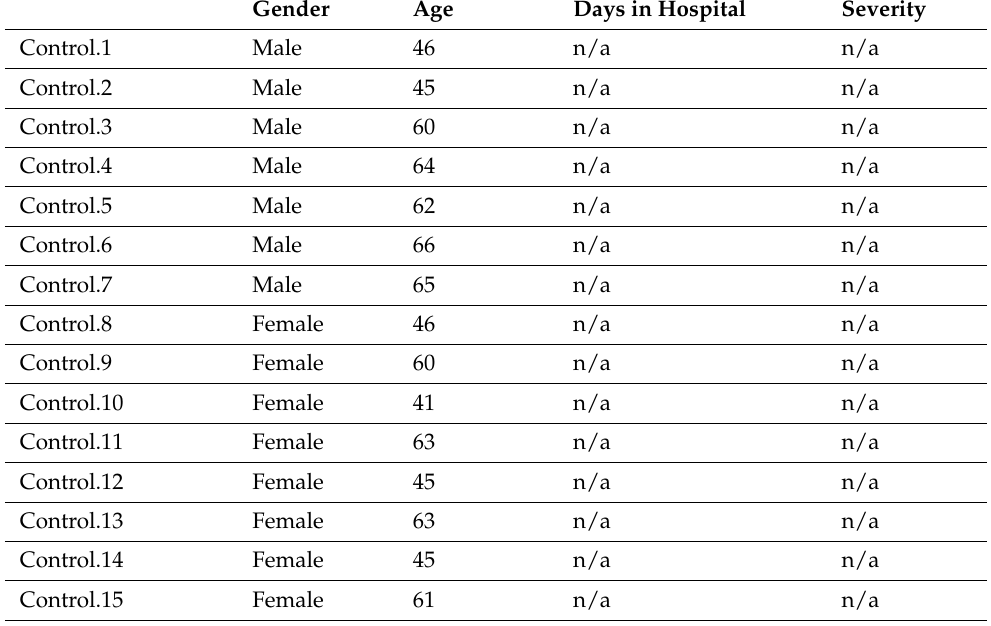
Table 2. Gender, age, days spent in hospital (if applicable), and severity of the pre-pandemic controls, COVID-19 patients at diagnosis, and post-COVID-19 patients 3 months after hospital discharged recruited in this